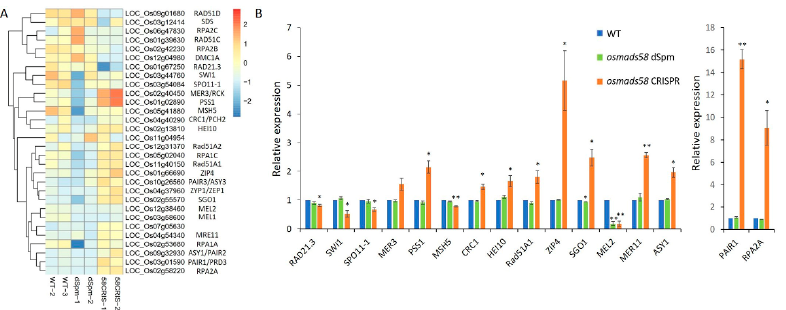
Figure 9. Expression profiles of meiotic genes in different samples and selected genes expression levels verification by RT-qPCR. ( A ) Known meiosis-related genes expression levels from the RNA-seq data. ( B ) RT-qPCR verification of the expression levels of selected meiotic genes. To better present the differences, the expression of two genes, PAIR1 and RPA2A , was separately plotted. Error bars indicate SD of three biological replicates. Student’s paired t -test: * p < 0.05, ** p <